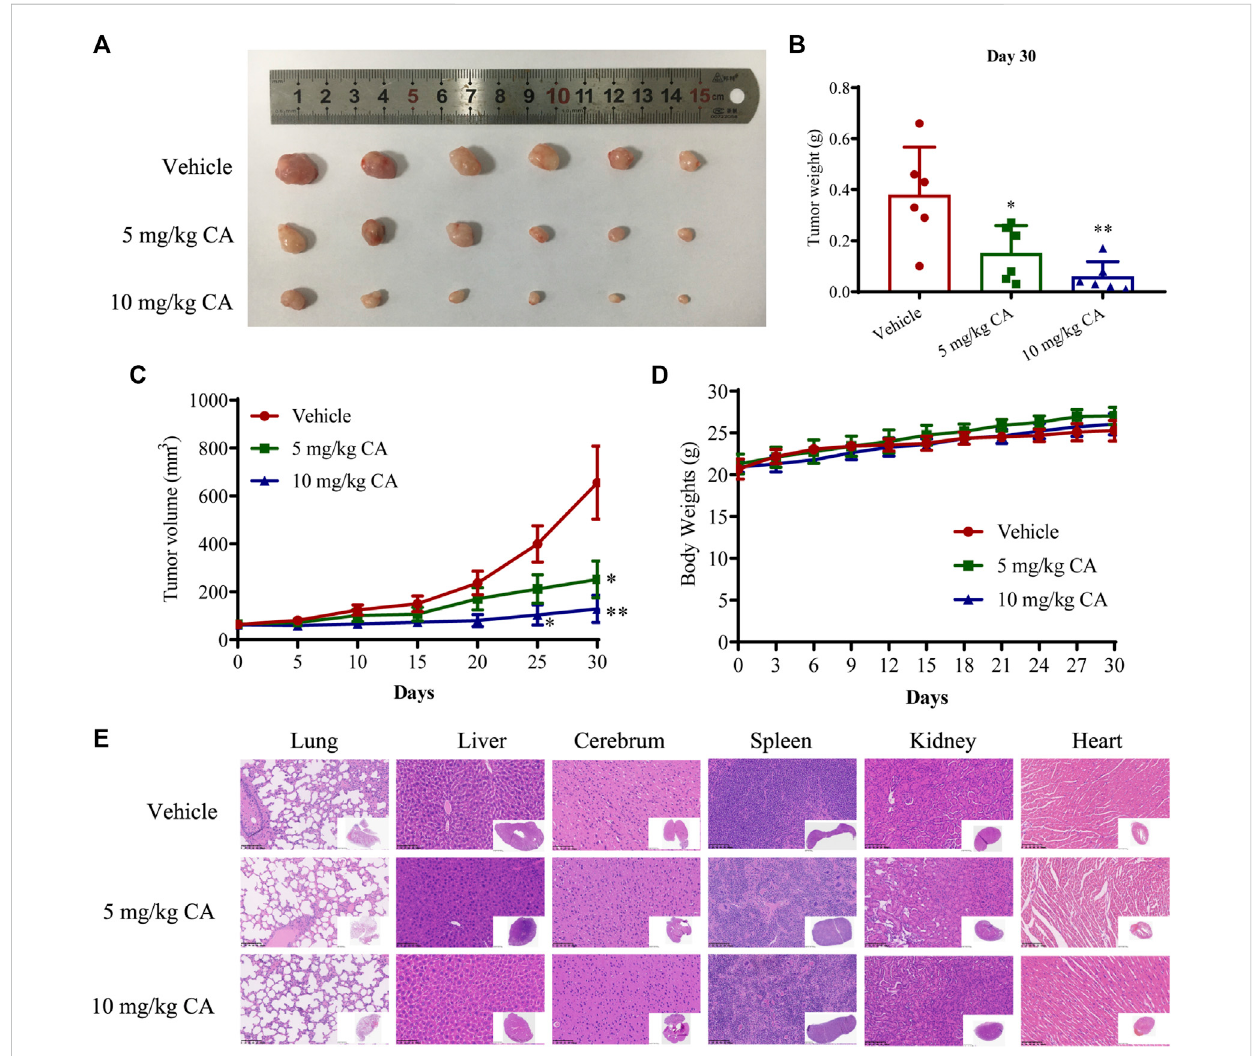
FIGURE 4 InhibitioneffectofCAontumorgrowthofGCinMKN1xenograftmicemodels. (A) TumorimageofMKN1xenograftmiceafter30 daysoftreatment with vehicle or CA (5 mg/kg and 10 mg/kg). (B) Tumor weight after 30 days of treatment with vehicle or CA (5 mg/kg and 10 mg/kg). (C) The tumor volumecurvesofmiceduring30 days. (D) Averagebodyweightofmiceduring30 days. (E) RepresentativeH&Estainingimagesoftheheart,liver,spleen, lung,kidney,andcerebrumofmice (400×).* p < 0.05,** p < 0.01 compared tothevehiclegroup(n =6).One-way ANOVAtest. Alldataare shownas the means ±